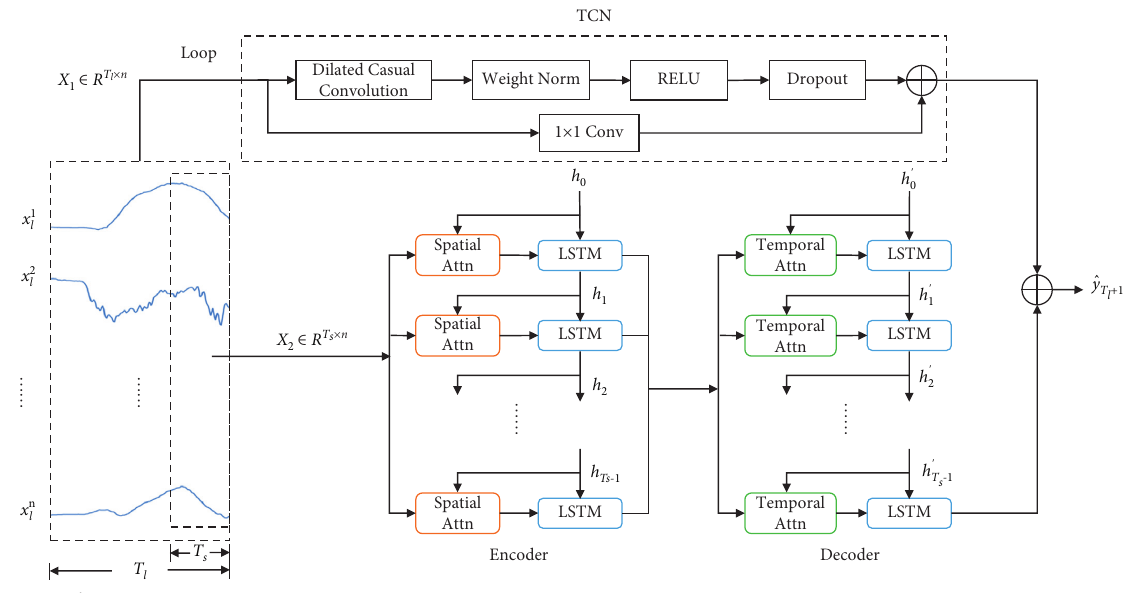
Figure 1: Framework of our method. T T n : the number of exogenous l : the window size of long series. s : the window size of short series. series. x i : i -th long exogenous series. h t : hidden state in the encoder at time t . h t ′ : hidden state in the decoder at time t . Spatial Attn: spatial l : the predicting value at time T l + attention module. Temporal Attn: temporal attention module. 􏽢 y T l + 1